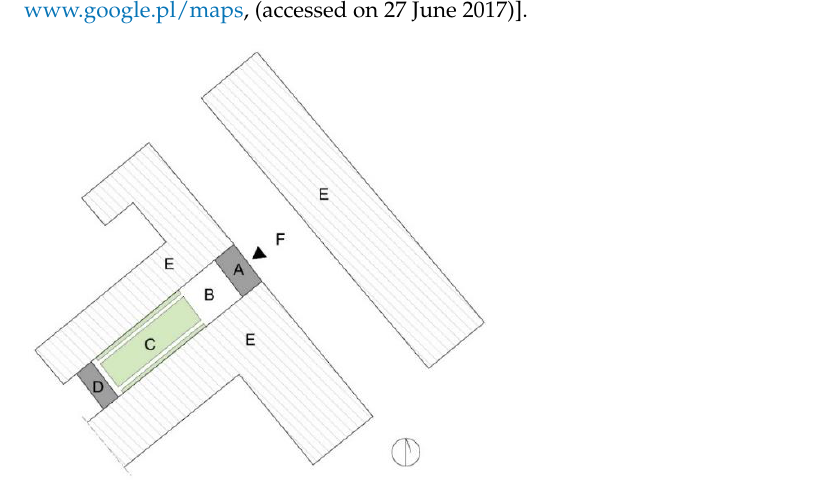
Figure 4. The diagram of the plan of the Passage 56 community garden in Paris, France. Legend: ( A ) pavilion with entrance gate, ( B ) recreational zone, ( C ) agrarian zone, ( D ) utility room and composter, ( E ) residential buildings, and ( F ) pedestrian and bicycle boulevard, [compiled by A. Nowysz, based on site visit (26.07.2016) and online source: www.google.pl/maps (accessed on 27 June 2017)].